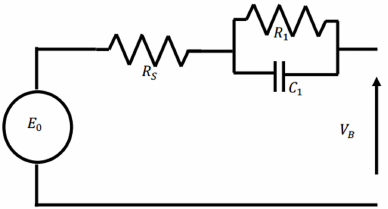
Figure 2. Equivalent lithium-ion circuit